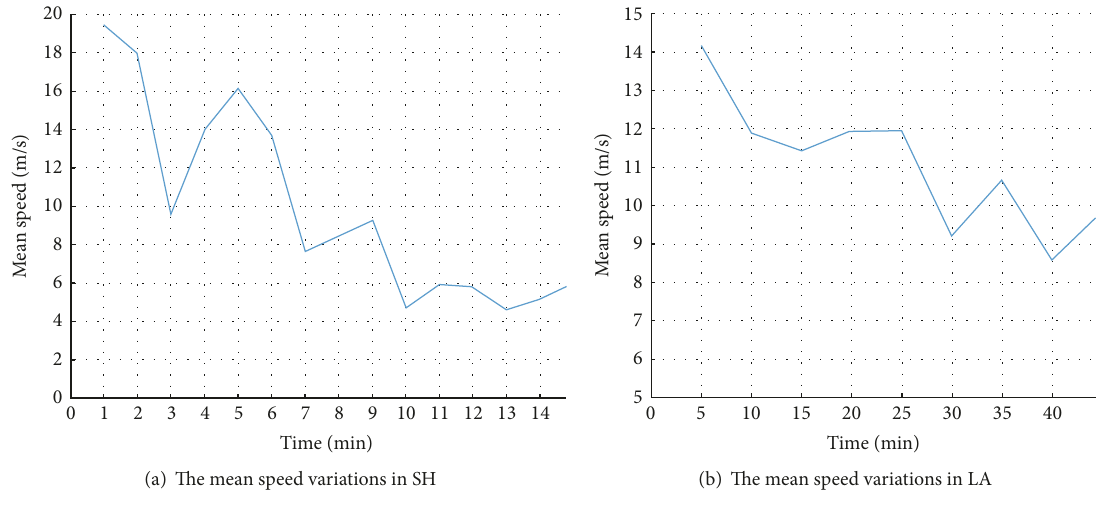
Figure 4: The mean speed variations in two datasets.